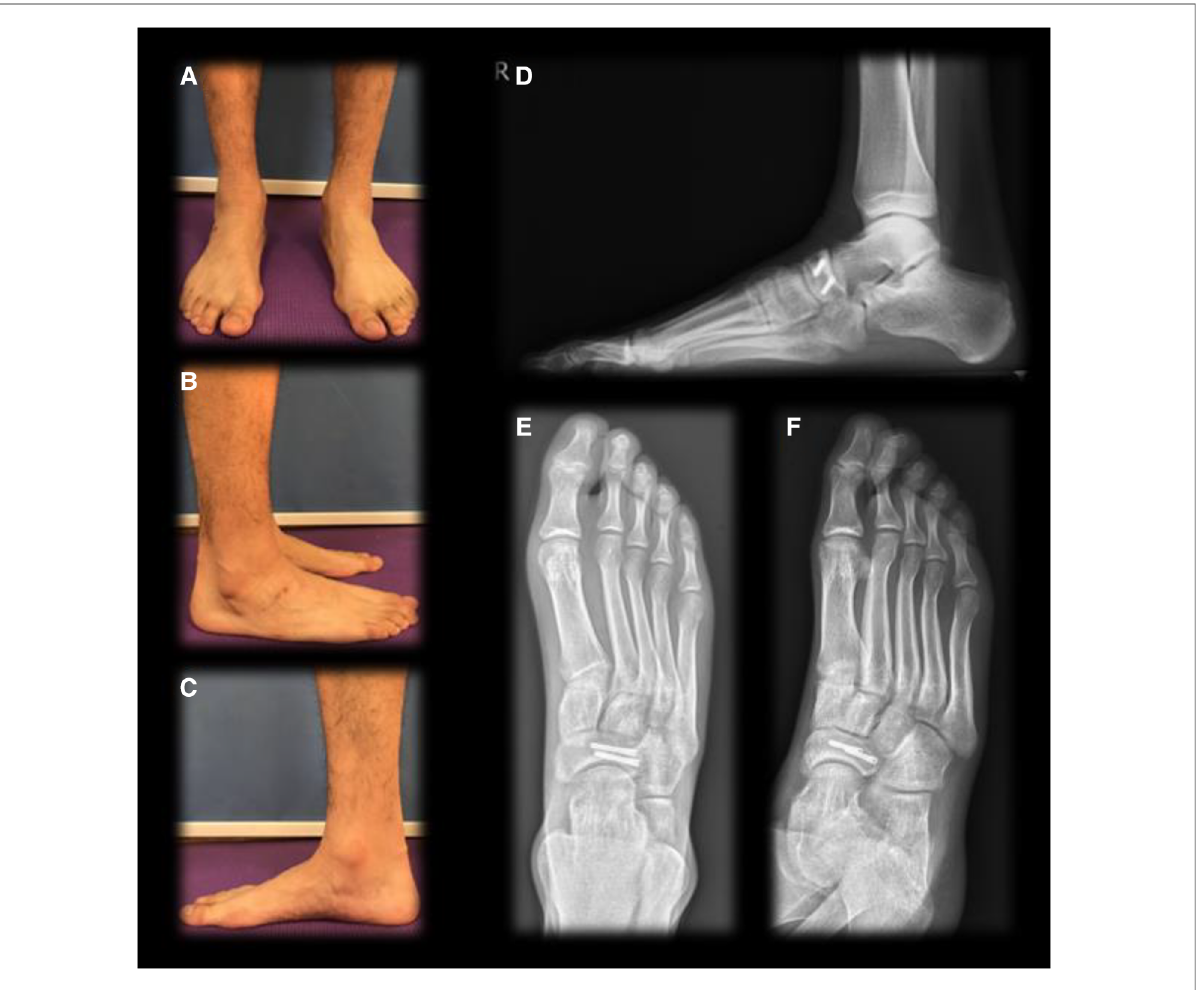
FIGURE 6 Twelve weeks postoperative follow-up. ( A ) Front view standing on two feet; ( B ) lateral view of the affected foot standing on two feet; ( C ) medial view of the affected foot standing on one foot; ( D ) weight-bearing lateral x-rayof the right foot; ( E ) anteroposternal x-rayof the right foot; ( F ) oblique x-ray of the right